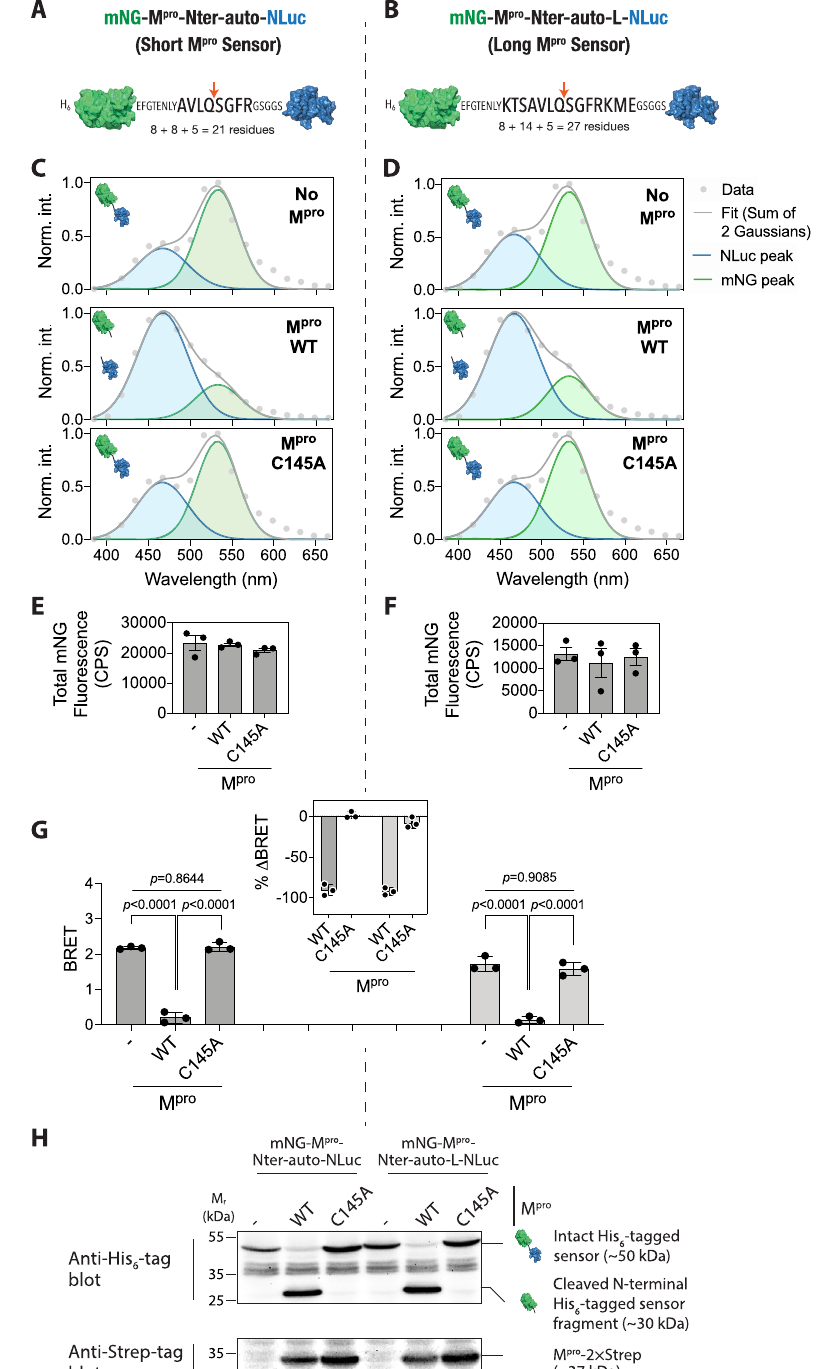
Fig. 3 Ef fi cient cleavage of the M pro sensor constructs in live cells. A , B Schematic showing the M pro sensor constructs — short ( A ) and long ( B ) — with SARS- CoV-2 M pro N-terminal autocleavage sequence. C , D Graph showing a representative bioluminescence spectra of the short ( C ) and long ( D ) M pro sensor constructs either in control cells or in cells expressing the WT or C145A mutant M pro . Data were fi t to a two Gaussian model re fl ecting mNG fl uorescence and NLuc bioluminescence peaks. Note the reduction in the mNG peak (533nm) of both the short and the long sensors when coexpressed with the wild type M pro while no reduction was observed when coexpressed with the C145A mutant M pro . E , F Graphs showing total mNG fl uorescence (measured prior to substrate addition) in cells expressing the short ( E ) and the long ( F ) sensors. G Graph showing BRET ratio (ratio emission at 533 and 467nm) of the short (left side) and the long (right side) M pro protease activity sensors in either control cells or when coexpressed with the wild type or the C145A mutant M pro . Note that data for both the short and the long sensor have been plotted on the same y -axis for the ease of comparison. Inset: graph showing percentage change in BRET of the short (left side) andthelong(right side) when co-expressed with thewildtypeor theC145Amutant M pro .Datashown aremean±S.D.fromthree independent experiments, each performed in triplicates. H Top panel: anti-His tag blot showing cleavage of the short (left side) and the long (right side) M pro sensor constructs in either control cells or in cells co-expressing the wild type or the C145A mutant M pro . Note the release of an approximately 30kDa, His 6 -tagged-mNG fragment in cells expressing the wild type but not in the C145A mutant M pro . Bottom panel: anti-Strep-tag blot showing expression of the M pro in the respectively transfected cells. COMMUNICATIONS CHEMISTRY| (2022) 5:117 |https://doi.org/10.1038/s42004-022-00731-2|www.nature.com/commschem